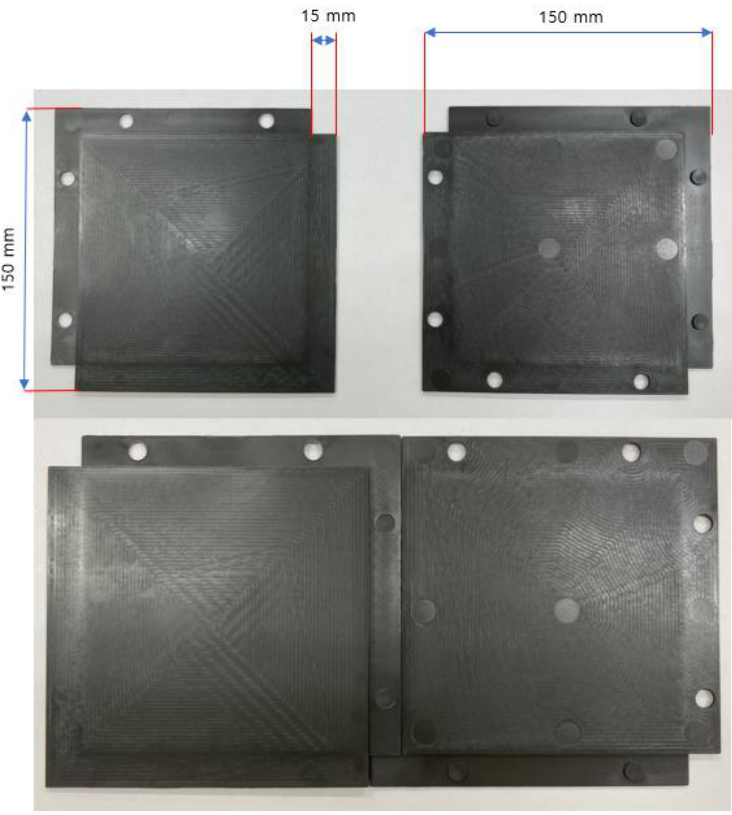
Figure 6. Final shielding barrier panel manufactured by injection molding.